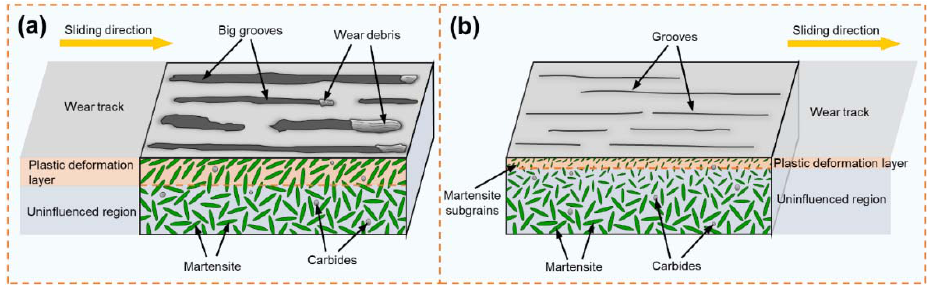
Figure 13. Schematic description of the wear mechanism influenced by USP treatment: ( a ) without USP treatment; ( b ) after USP treatment.